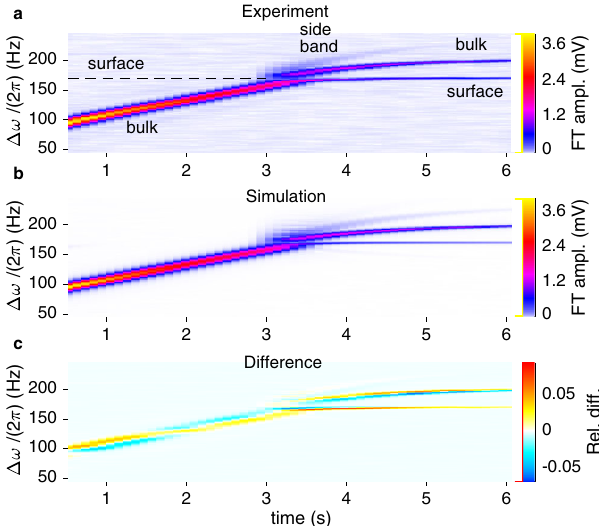
Fig. 3 Two-level time crystal dynamics at small N B . a The signal from the pick-up coils, analysed with windowed Fourier transformation (FT), shows the bulk time crystal as a moving sharp peak. Frequency is plotted in the rotating frame Δ ω = ω − ω 0 . The excitation pulse at t = 0 is framed out for clarity. Initially ω B < ω S , but as the population in the bulk trap decays, at t = 3.3s, the global ground state moves to the surface in an avoided crossing. The excited state, now located in the bulk, is simultaneously populated. Rabi (Josephson) population oscillations are seen as a side band. Coupling extracted from the side band extrapolates to Ω /(2 π ) = 1.7±0.4Hz at the crossing, in good agreement with the fi tted simulation value Ω /(2 π ) ≈ 1.4Hz. b The numerical simulation recreates the population transfer and the side band, con fi rming that the population transfer is due to Landau-Zener transition (analysis in Fig. 4). In the absence of measurement noise also the side band of the surface time trace is weakly visible. c Subtracting the simulation from the experiment shows that the point-wise residuals remain smaller than 5%. The relative difference is normalised by the total signal at the crossing. In this measurement temperature was 180 μ K and ω 0 /(2 π ) =